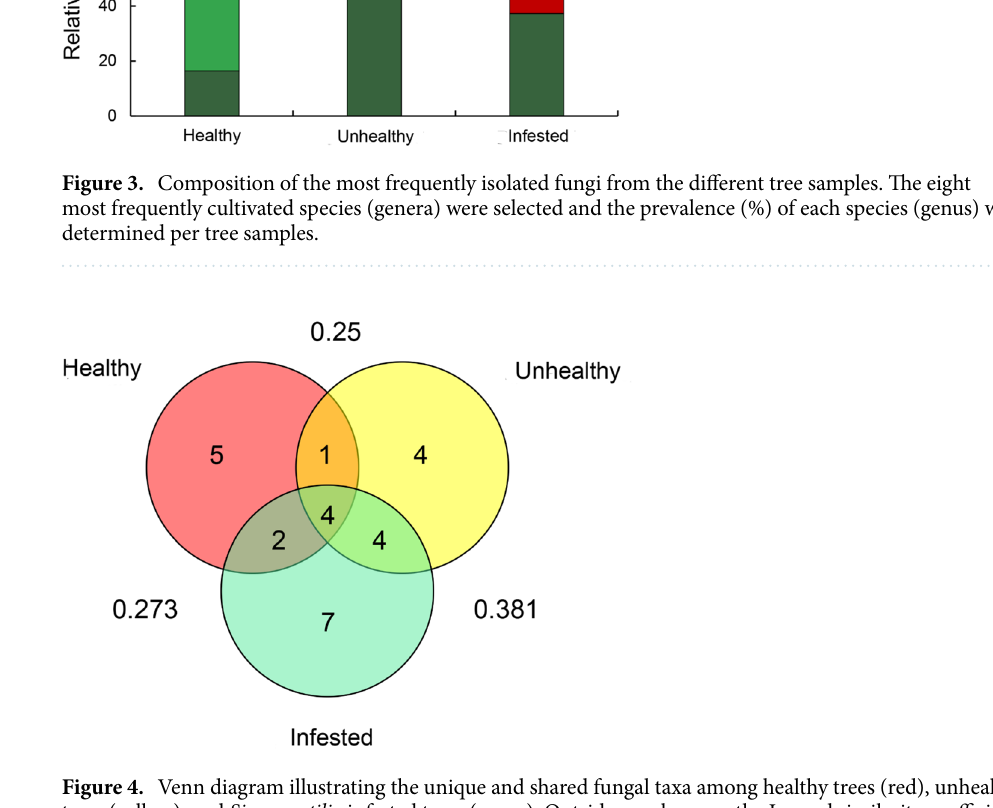
Figure 4. Venn diagram illustrating the unique and shared fungal taxa among healthy trees (red), unhealthy trees (yellow), and Sirex noctilio infested trees (green). Outside numbers are the Jaccard similarity coefficient.